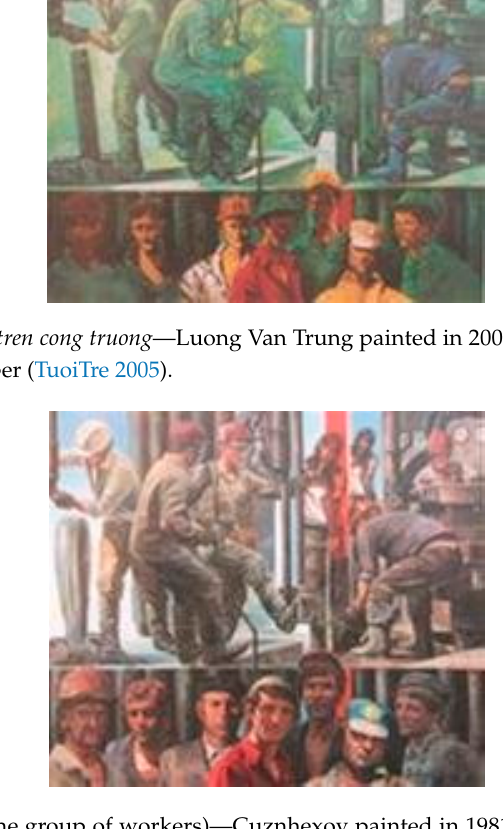
Figure A26. Brigada (The group of workers)—Cuznhexov painted in 1981. The image was sourced from Tuoi Tre Newspaper (TuoiTre 2005).